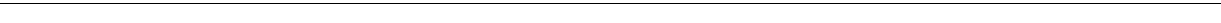
Figure 3 | Stat3 induces centrosome clustering via Stathmin and is independent of Stat3 transcription factor function. ( a ) Quantification of centrosome declustering in BT-549 cells treated with the protein synthesis inhibitor cycloheximide (left panel; n ¼ 5 biological replicates, Z 1,000 cells per data point) and the transcription inhibitor actinomycin D (right panel; n ¼ 5 biological replicates, Z 1,000 cells per data point). ( b ) Transcriptional reporter activity of cells treated with Stattic, cycloheximide or actinomycin D. n ¼ 4 biological replicates. Statistical significance was tested between untreated and compound- treated groups with analysis of variance (ANOVA). ( c ) Quantification of centrosome declustering in mitotic BT-549 cells treated with epidermal growth factor (EGF; left; n ¼ 5 biological replicates, Z 1,000 cells per data point) or the EGF receptor inhibitor erlotinib (right; n ¼ 5 biological replicates, Z 1,000 cells per data point). Statistical significance was tested between untreated and compound-treated groups with ANOVA. ( d ) Quantification of centrosome declustering in BT-549 cells treated with the Jax1/2 inhibitor ruxolitinib. n ¼ 5 biological replicates, Z 1,000 cells per data point. Statistical significance was tested between untreated and ruxolitinib-treated groups with ANOVA. ( e ) Left: quantification of centrosome declustering in Stat3 siRNA-treated mitotic BT-549 cells stably expressing Flag-Stat3C or Flag-Stat3-Y705F ( n ¼ 5 biological replicates, 250 cells per condition). Right: western blot of Flag, Stat3 and GAPDH (loading control) using lysates from Stat3 siRNA-treated cells stably expressing Flag-Stat3C or Flag-Stat3-Y705F. Statistical significance between the indicated groups was tested using ANOVA. ( f ) Immunofluorescence images of Stat3 siRNA-treated BT-549 cells stably expressing Flag-Stat3C (left) or Flag-Stat3-Y705F (right). Pericentrin (red), Flag (green) and DNA (Hoechst, blue). Scale bar, 4 m m. ( g ) Quantification of centrosome declustering in BT-549 cells treated with Stathmin siRNA ± Stattic. n ¼ 4 biological replicates, Z 800 cells per condition. Statistical significance was tested between untreated and Stattic-treated groups with ANOVA. ( h ) Western blot of Stathmin and actin (loading control) using lysates from Stathmin siRNA-treated cells. ( i ) Immunoprecipitation of IgG (control) or Stat3 from BT-549 cells using endogenous protein and western blotted for Stathmin, Stat3 and IgG. ( j ) In vitro tubulin polymerization assay using purified proteins. Microtubules were grown in the presence of the microtubule depolymerase Stathmin (HIS-tagged), Stat3 (GST-tagged), Stattic and BBI-608. HIS-Stathmin and GST-Stat3 were used at 1.8 and 0.36 m M concentrations, respectively. Scale